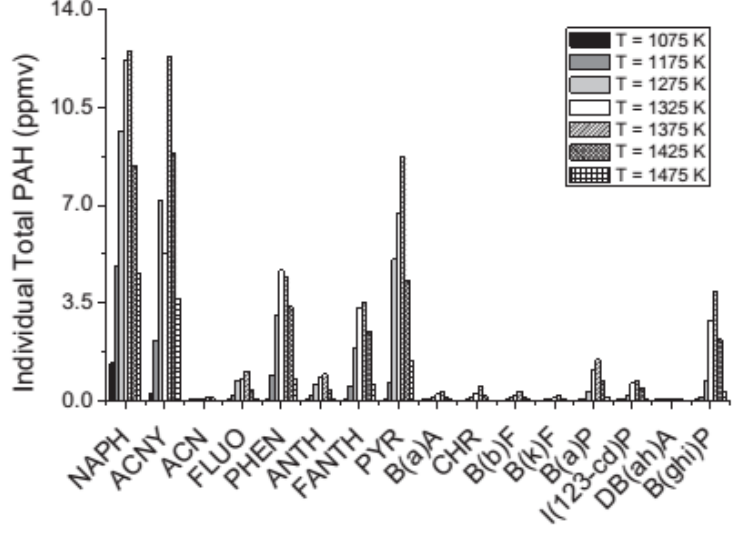
Figure 7. PAH concentrations at different reaction temperatures